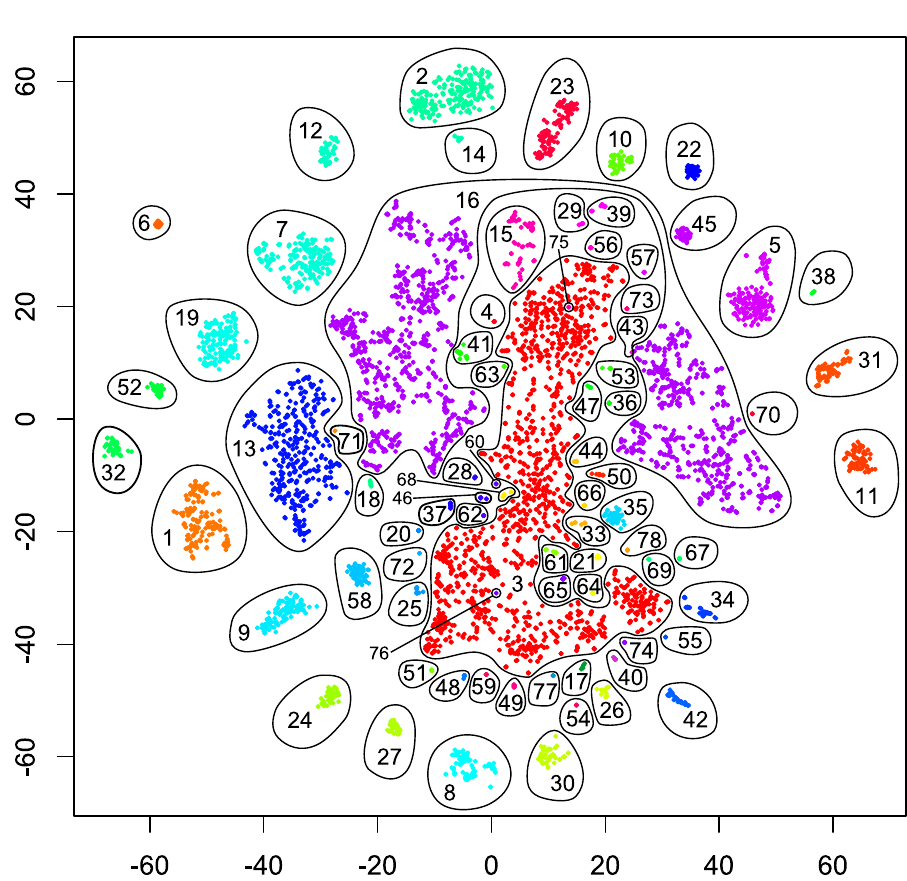
Fig 2. t-SNE plot of 5,817 viruses from RefSeq, grouped by mutual information of genes in common and 4-mer frequency. Points are colored according to 78 clusters assigned by density-based clustering in the 3-dimensional t-SNE space. Each cluster is numbered, and cluster numbers correspond to those in Fig 5. Most clusters correspond to one order or family in the ICTV classification.